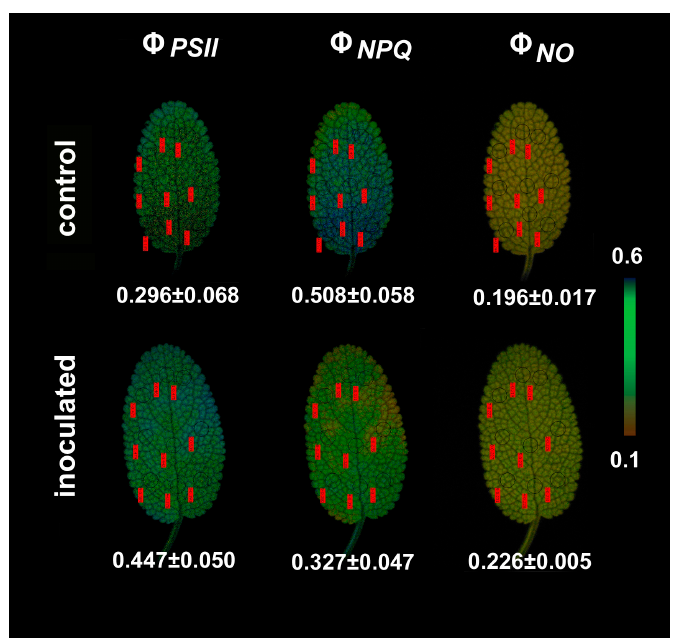
Figure 9. Representative chlorophyll a fluorescence images of the effective quantum yield of PSII photochemistry ( Φ PSII ), the quantum yield of regulated non-photochemical energy loss in PSII ( Φ NPQ ), and the quantum yield of non-regulated energy loss in PSII ( Φ NO ) of Salvia fruticosa leaves from control (non-inoculated) and inoculated plants. The color code depicted at the right side of the image ranges from values 0.1 to 0.6. The nine areas of interest (AOI) are shown in each image. The average value ( ± SD) of the whole leaf for each parameter is shown.